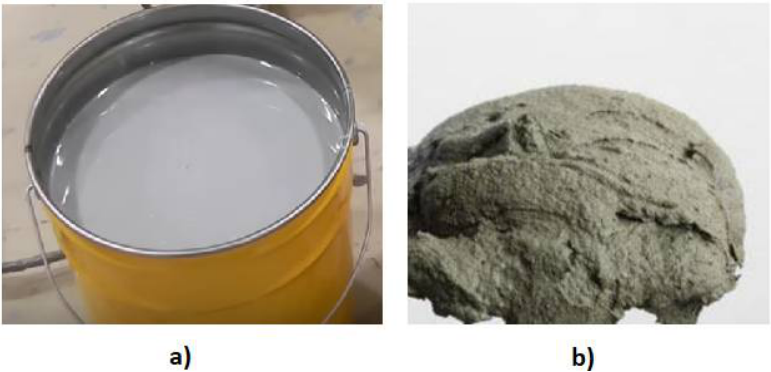
Figure 8 . Example of the matrix in the laminate: ( a ) epoxy resin and ( b )